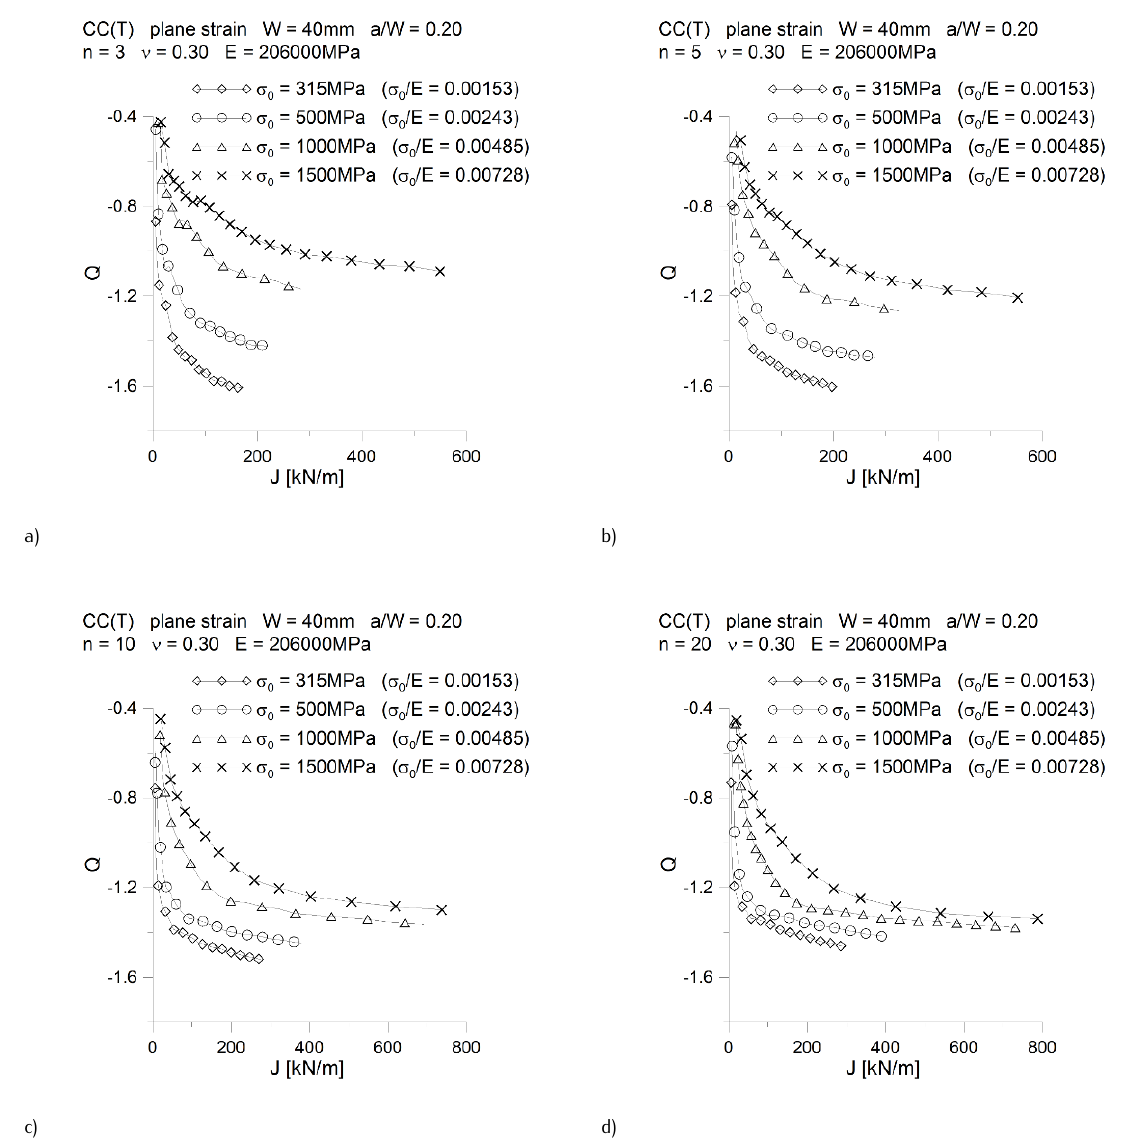
Figure 18. The influence of the yield stress on J - Q trajectories for CC(T) specimens with crack length a / W =0.20 for different power exponents in R-O relationship: a) n =3; b) n =5; c) n =10; d) n